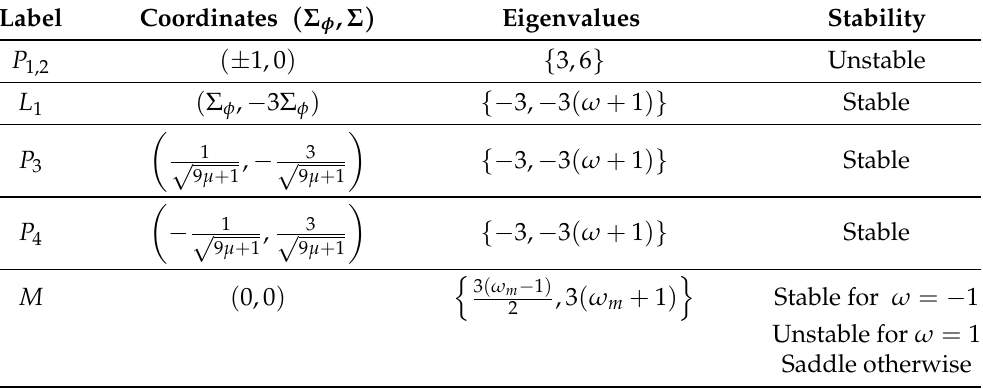
Table 5. Equilibrium points of System (85) and (86) for (cid:101) = + 1 with their eigenvalues and stability. Label